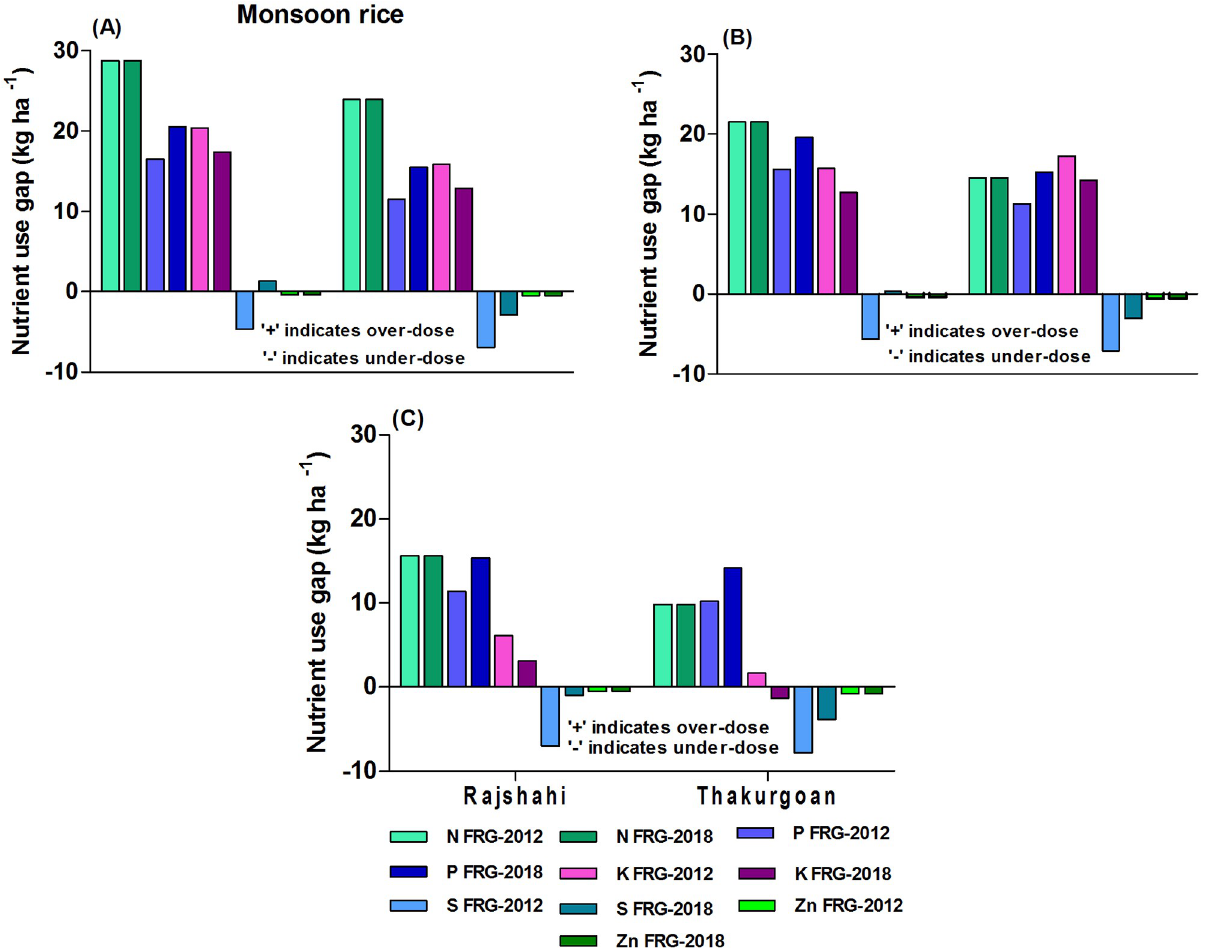
Fig 5. Farms’ current nutrient use gaps relative to FRG-2012 and FRG-2018 for monsoon rice: A) large-scale farms B) medium-scale farms C) small-scale farms in the potato-maize-monsoon rice cropping pattern here.